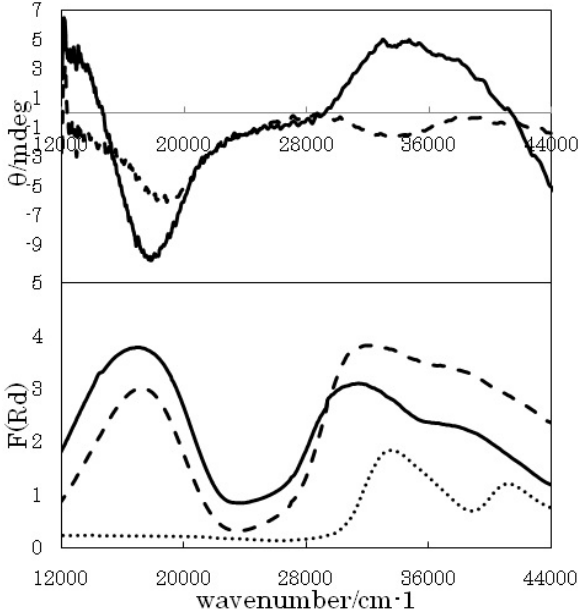
Figure 4. Solid state CD and diffuse reflectance electronic spectra for Cu-W-RR-dm (solid lines), the corresponding Cu-precursor (broken lines), and the W-precursor (dotted